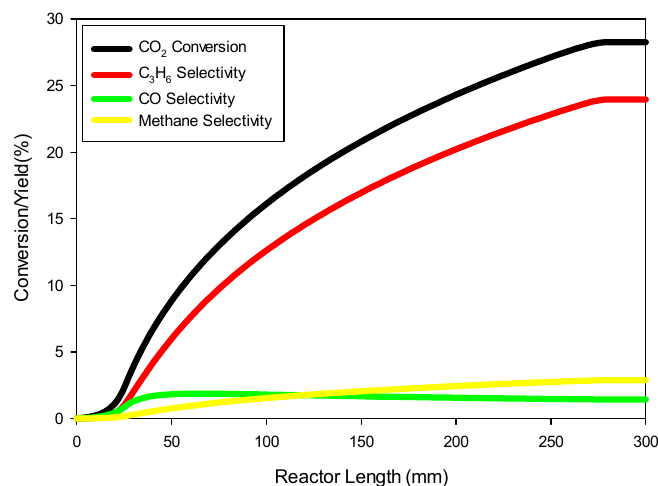
Figure 8. Profiles of percent CO 2 conversion (black), and percent C 3 H 6 (red), CH 4 (yellow), and CO